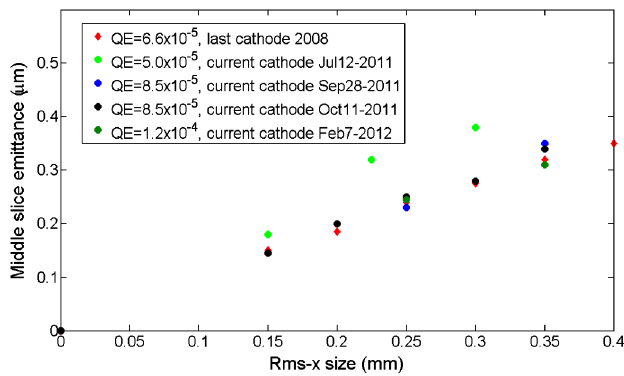
FIG. 9. Thermal emittance for the previous 2nd LCLS cathode (red squares), which was never laser-cleaning processed, and the current third LCLS cathode, which was processed by the laser cleaning. Laser cleaning of the current cathode was performed on July 4,